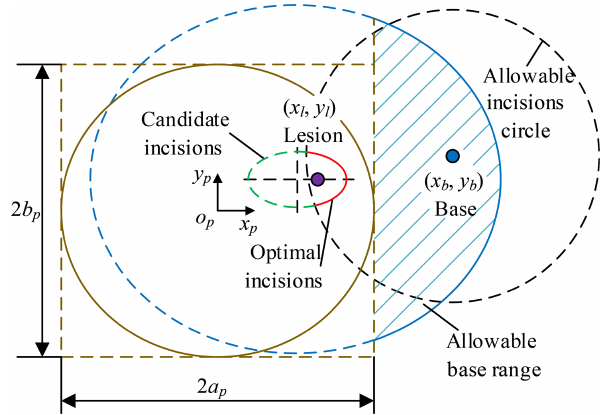
Figure 11. The schematic diagram of optimum incisions.